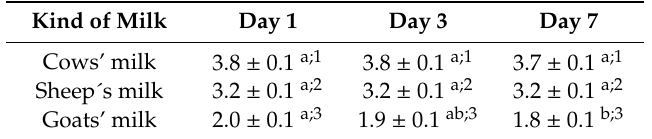
Table 1. Number of lactobacilli colonies (log CFU / mL) obtained by culture microbiological examination of milk samples using de Man, Rogosa, and Sharpe (MRS) agar medium (mean ± SD).